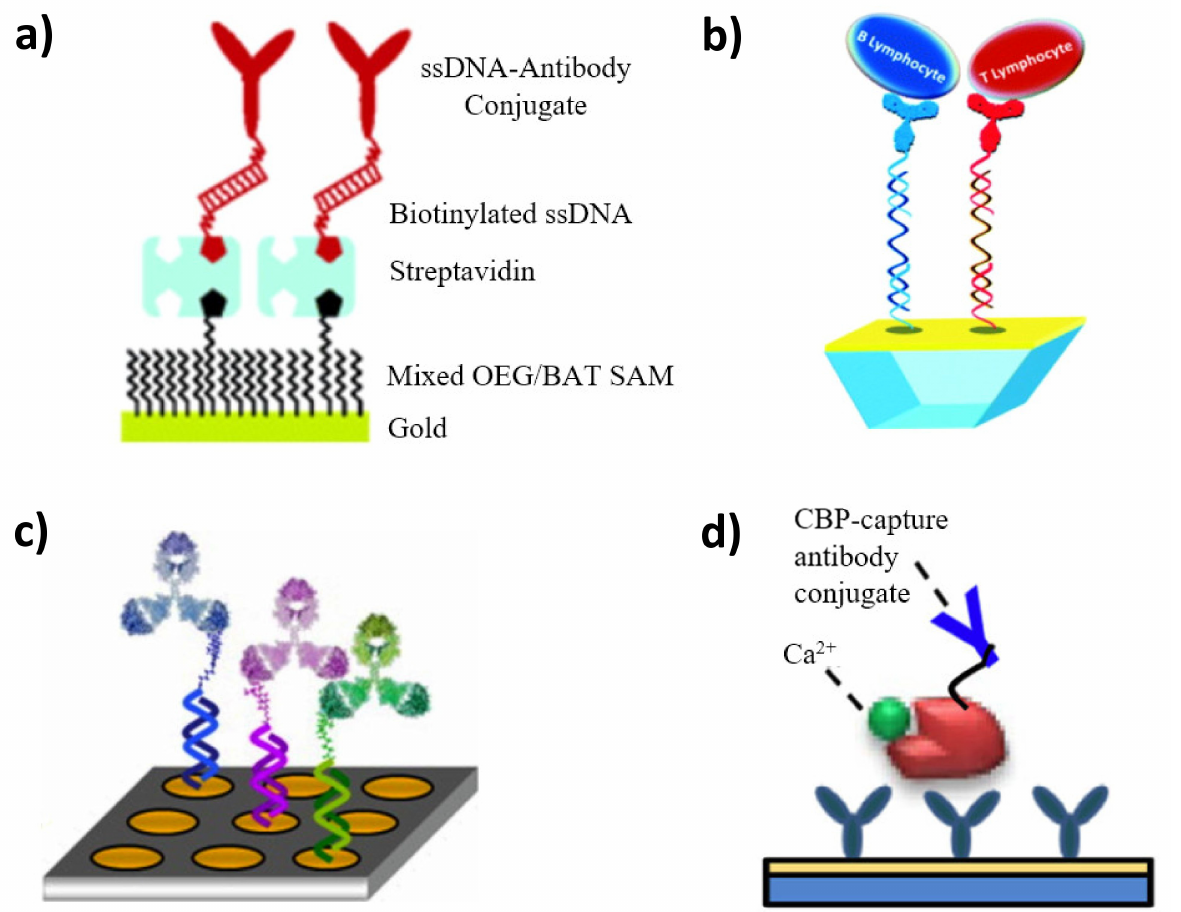
Figure 8. Various concepts of DNA-directed immobilization in the construction of SPR immunosensors: ( a ) immunosensor based on DNA anchoring via Av-Bt affinity, ( b ) direct SPRi assay for the detection of lymphocytes, employing DNA hybridization in sandwich-like format, ( c ) competitive SPRi immunoassay with the use of DNA-steroid conjugates, ( d ) immunosensor using Ca 2+ -dependent antibody-directed immobilization. Adapted with permission from Ladd et al. [167] (Copyright © (2004) American Chemical Society), Leroy et al. [170] (Copyright © (2004) Royal Society of Chemistry), Tort et al. [172] (Copyright © (2012) American Chemical Society), and Kim et al. [173] (Copyright © (2017)